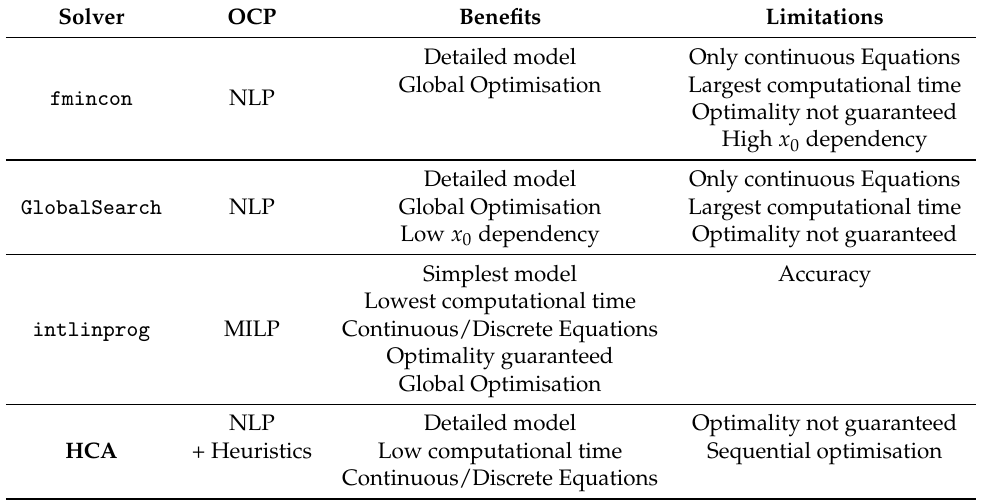
Table 2. Benefits, limitations and optimal control problems (OCP) fed into the different optimisation solvers. x 0 refers to the starting point provided to solvers fmincon and GlobalSearch